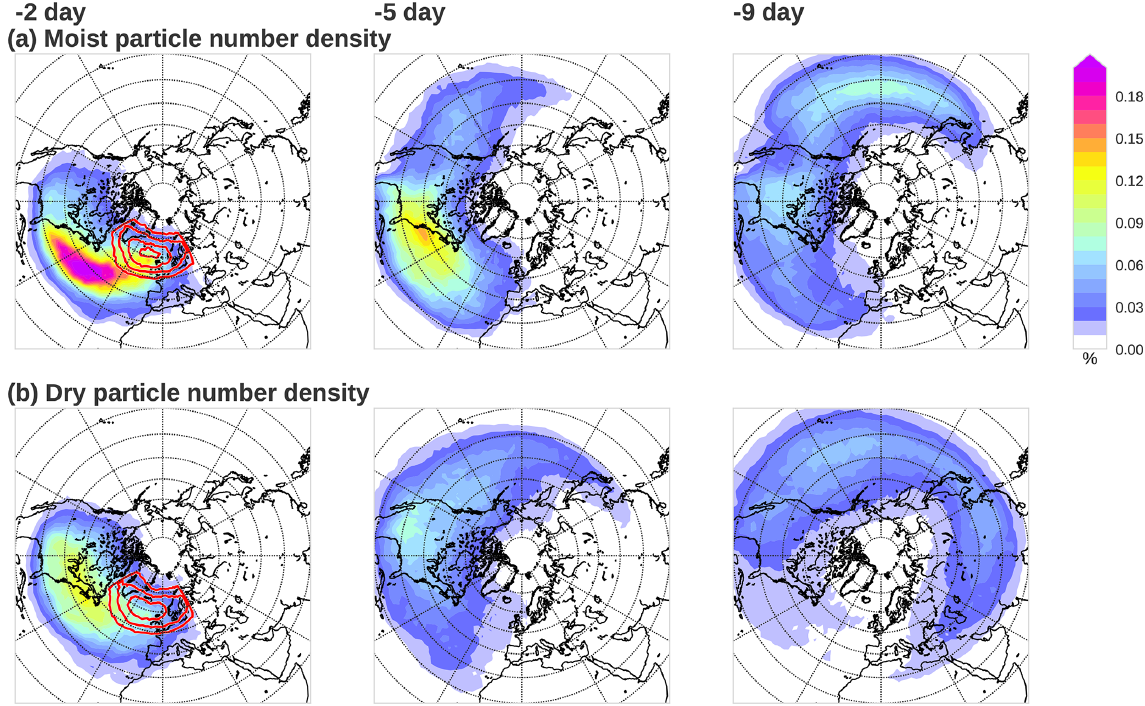
Figure 2. Number density for each 2 ◦ × 2 ◦ grid cell for the moist particles (a) and dry particles (b) 2d (left column), 5d (middle column), and 9d (right column) prior to their arrival in the wintertime Euro-Atlantic blocking highs. Red contours denote the location of the particle release (i.e., where the blocks form) with the interval of 0.05% starting from 0.1%. In each panel the sum of all grid cells is 100%. Parallels are plotted for every 10 ◦ , whereas meridians are plotted for every 30 ◦ on each